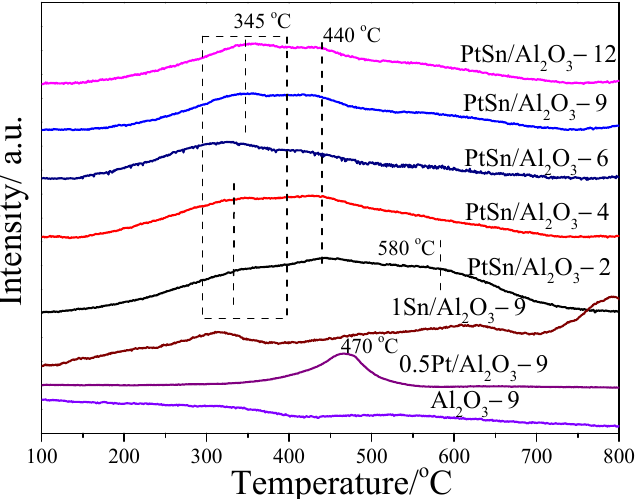
Figure 4. H 2 -TPR curves of Al 2 O 3 -9, 0.5Pt/Al 2 O 3 -9, 1Sn/Al 2 O 3 -9 and PtSn/Al 2 O 3 catalysts.